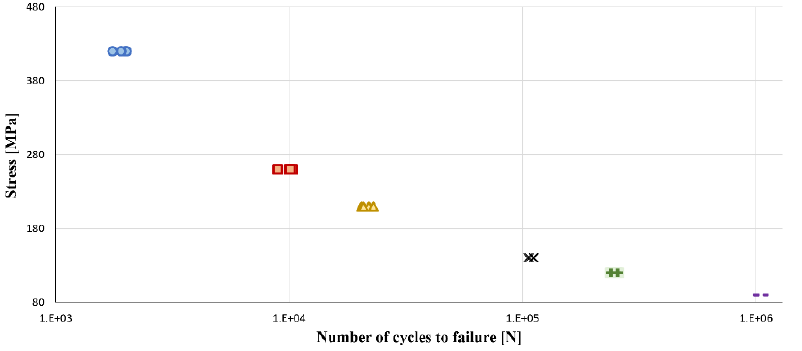
Figure 4. Axial fatigue test results for standard samples fabricated from IPE-220 steel pile.